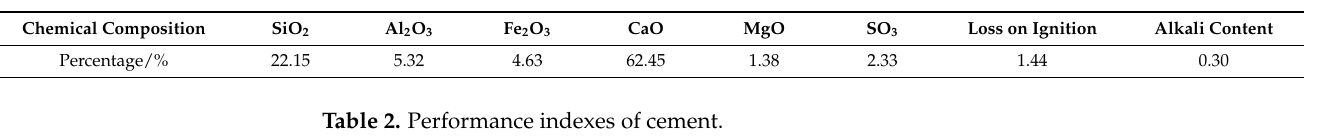
Table 1. Chemical composition of cement.